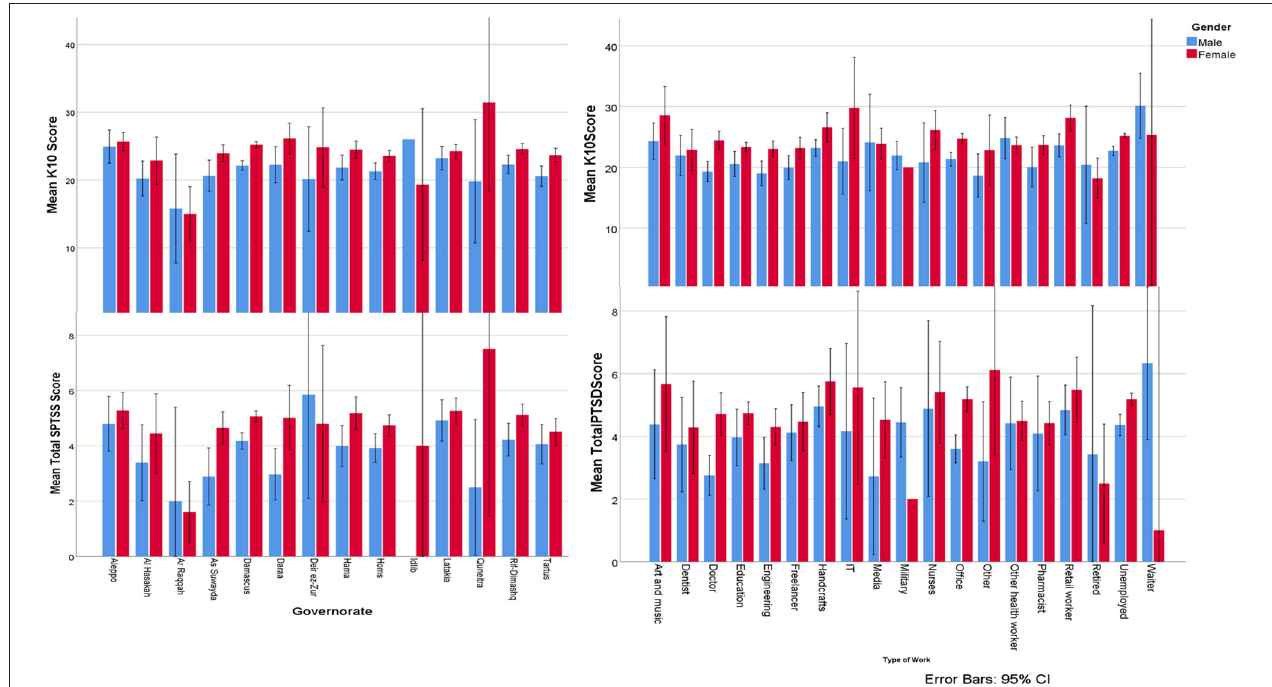
FIGURE 1 | SPTSS and K10 scores by gender distribution according to the type of work and governorates.